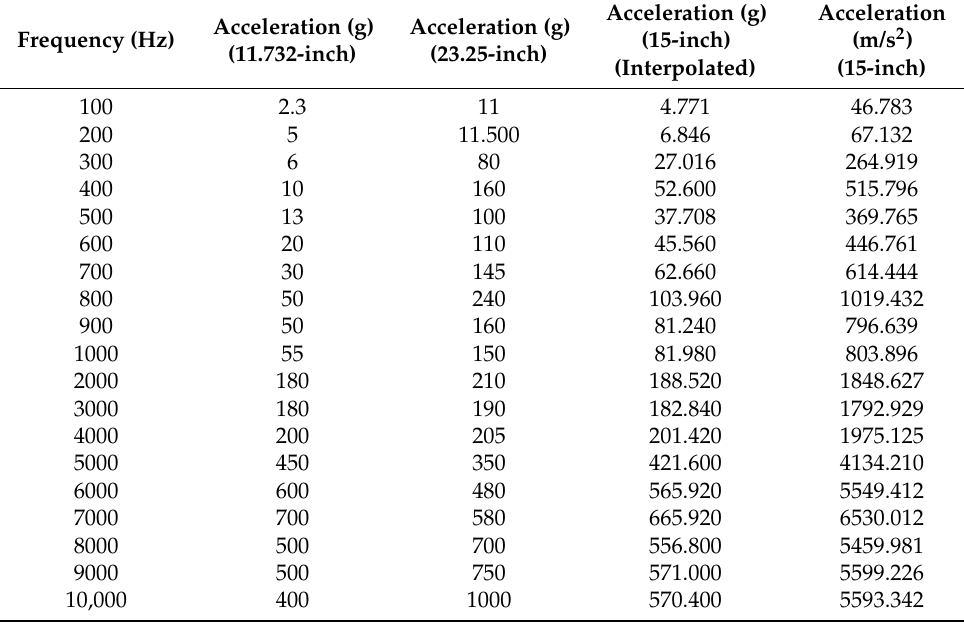
Table 3. Shock response spectrum for 15-inch diameter Lightband